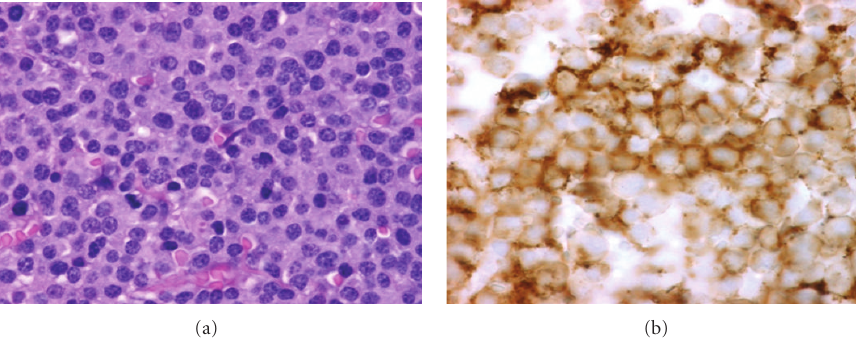
Figure 2: (a) Microscopic image of the submucosal subglottic portion of the mass after staining with hematoxylin and eosin. It shows intense basophilic plasma cells. (b) Microscopic image showing a positive CD138 marker at the immunohistochemical study.